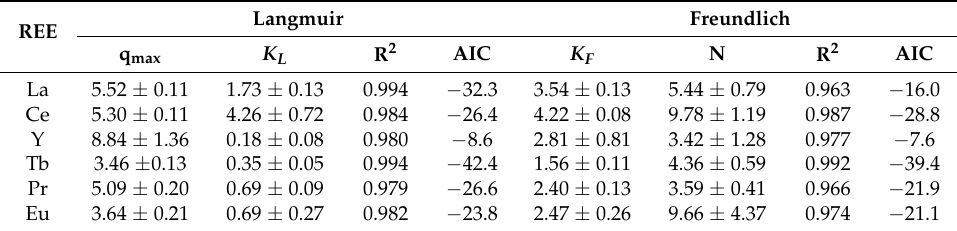
Table 8. Langmuir and Freundlich isotherm fittings for single-solute solutions in zeolite.